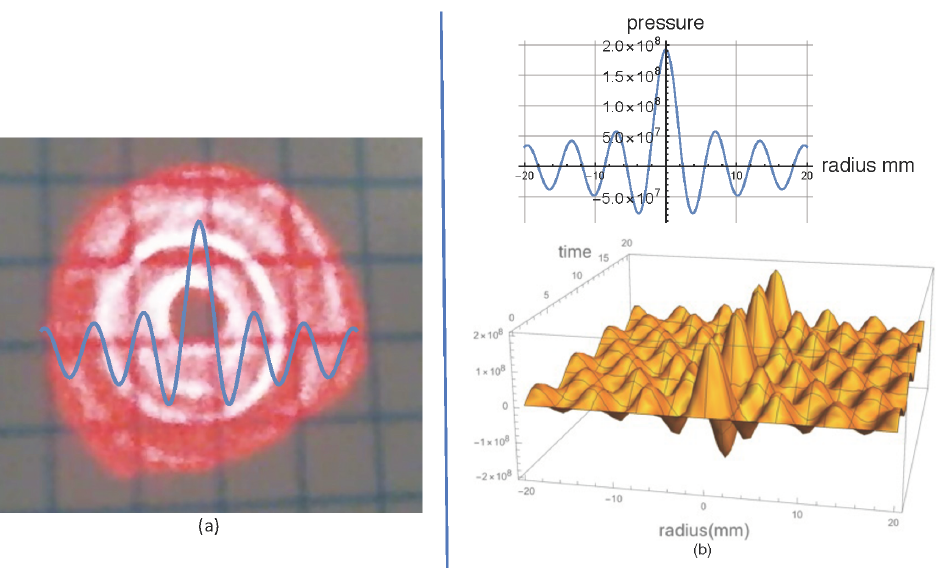
Figure 4. A Bessel function fit of image of the analog black hole. Panel ( a ) shows the fit to the image, and panel ( b ) shows the 3D radius, pressure, and time